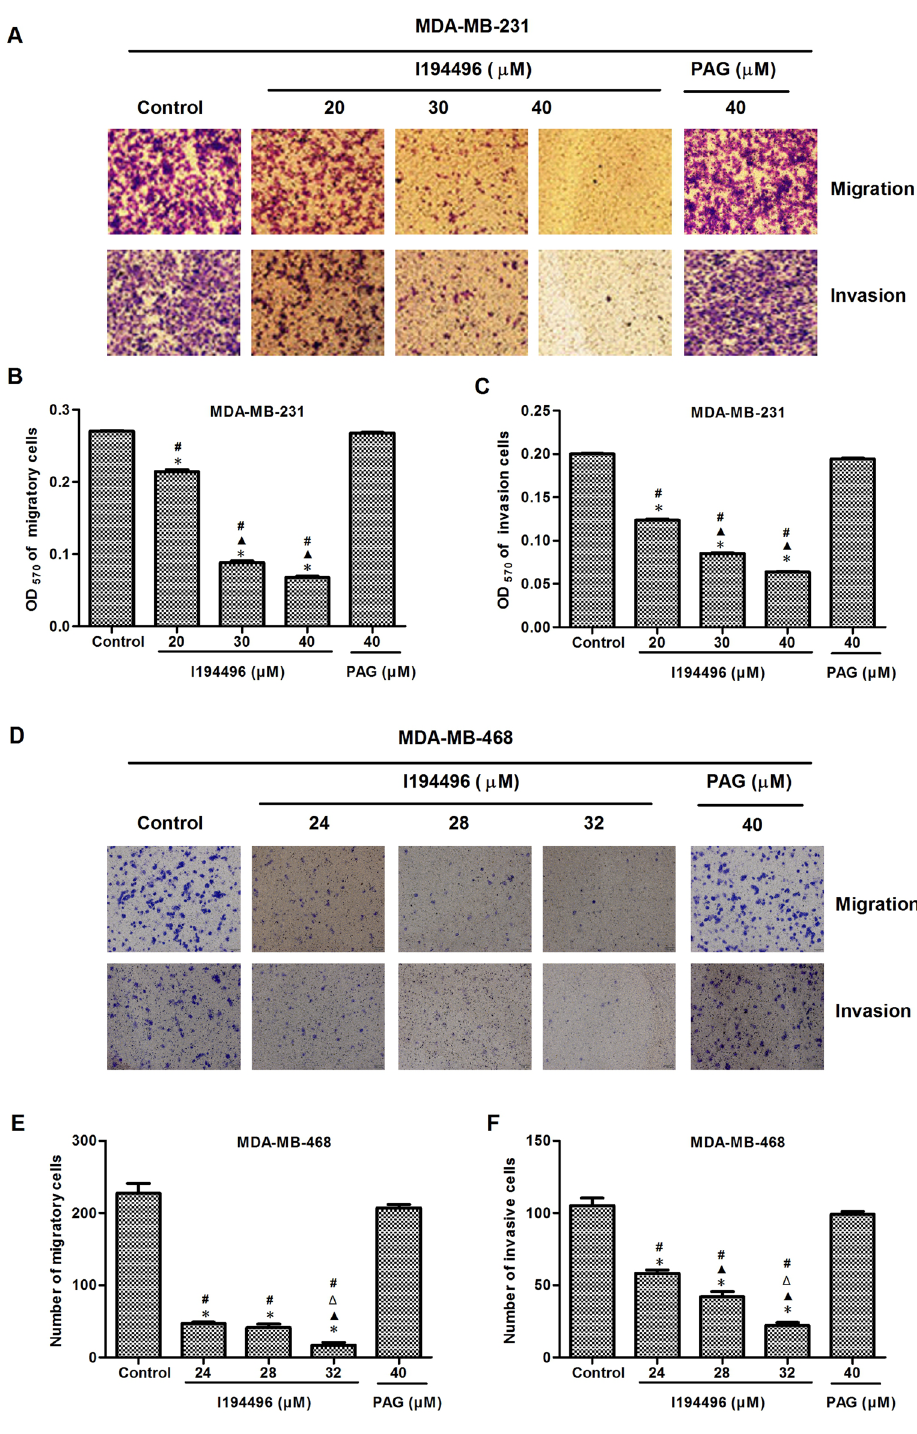
Figure 4. I194496 inhibits the migration and invasion of TNBC cells. ( A – C ) The effect of I194496 on the migration and invasion of MDA-MB-231 cells. *P < 0.05 vs Control group. ▲ P < 0.05 vs 20 μM I194496 group. # P < 0.05 vs PAG group. ( D – F ) The effect of I194496 on the migration and invasion of MDA-MB-231 cells. *P < 0.05 vs Control group. ▲ P < 0.05 vs 24 μM I194496 group. Δ P < 0.05 vs 28 μM I194496 group. # P < 0.05 vs PAG group. Image magnification, ×